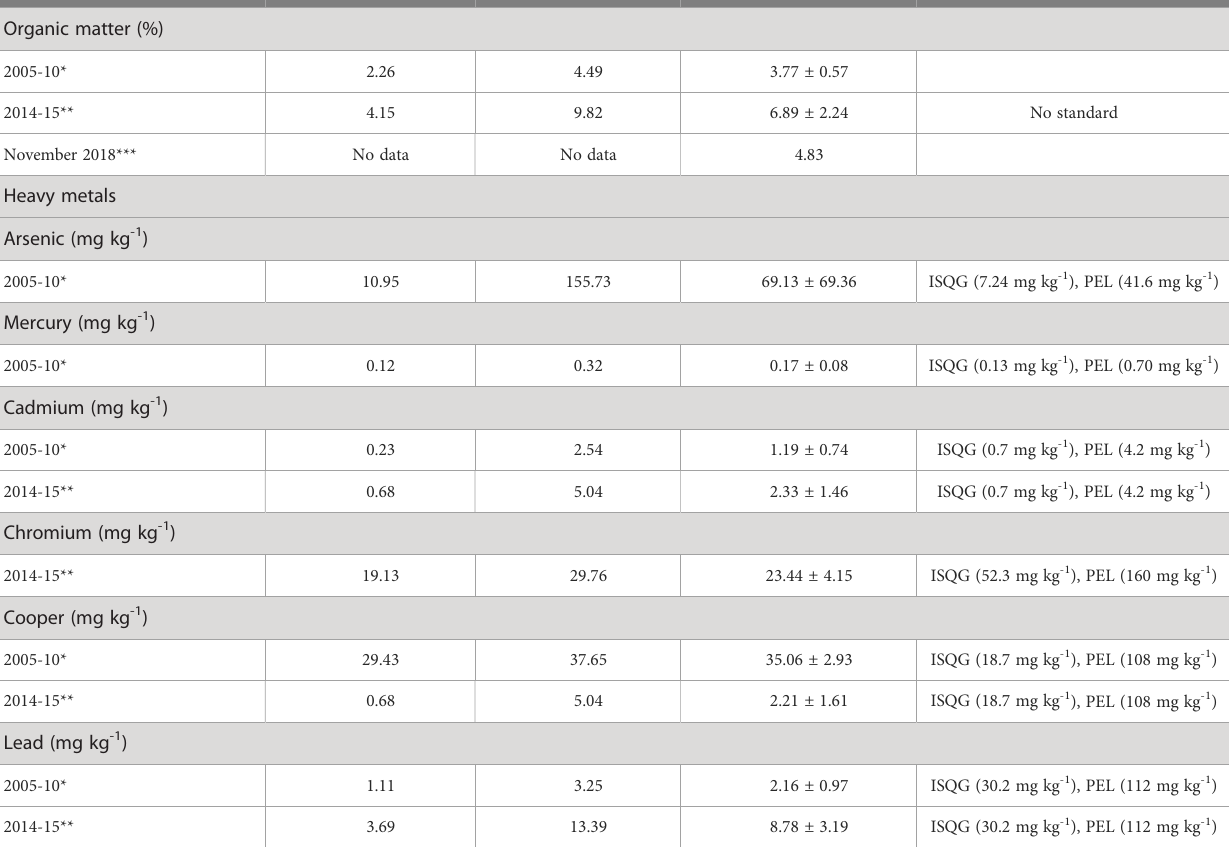
TABLE 2 Organic and inorganic water pollution in Samanco Bay during the period 2005-10, 2014-15, and November 2018.